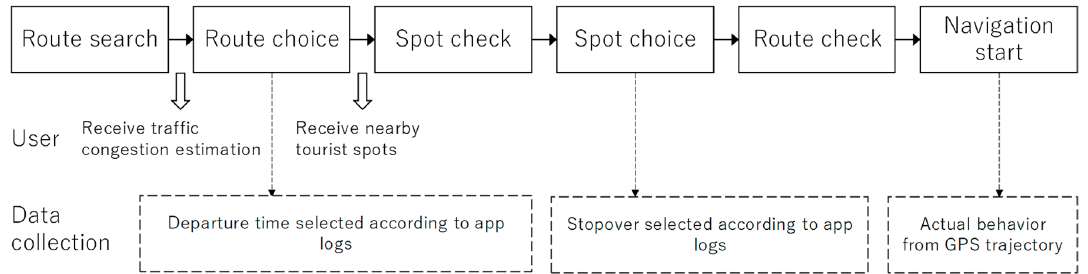
Figure 1. Use and data collection of the mobile app.